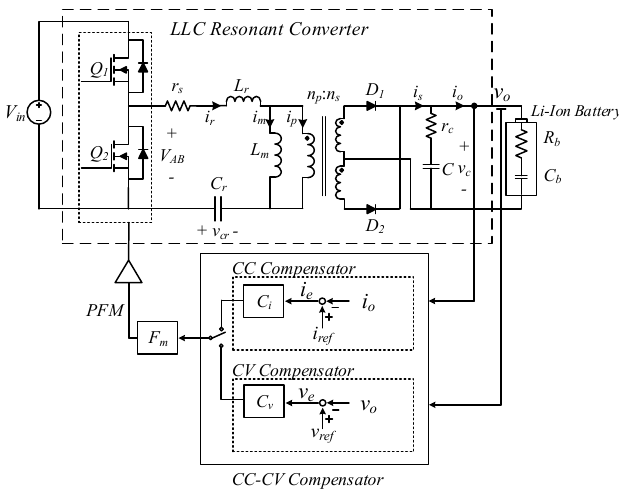
Figure 1. The battery charger including the conventional separated compensators.